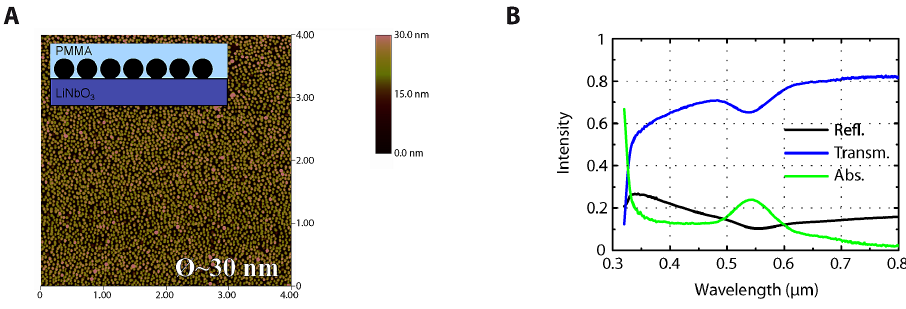
Figure 6: Characteristics of the tested nano-sphere sample. a , AFM picture of a region of the sample reveals a loosely packed area of arbi- trarily scattered, non-stacked spheres on a substrate, e.g. LiNbO 3 . Elevation levels show that the spheres are between 20 and 30nm in di- ameter. After this measurement, the spheres were encased in a protective PMMA layer. b , (Simulated) optical characterisation of the global sample shows a broad resonance around 540nm , but no spectral feature at the laser wavelength of 800nm (AFM image and simulation courtesy of J.